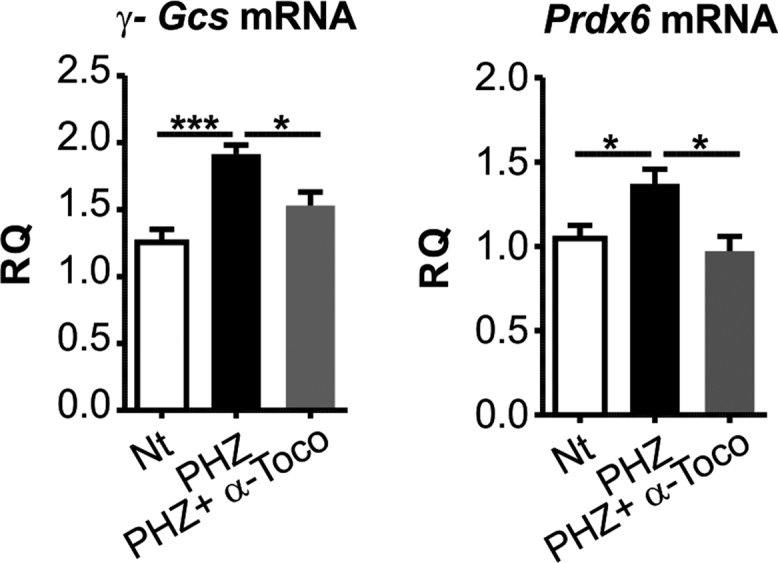
α-tocopherol protects the heart against PHZ-mediated oxidative stress. Data on the heart of PHZ-treated Wt mice administered or not with α-tocopherol are shown. (A) qRT-PCR analysis of γ-Gcs and peroxiredoxin 6 (Prdx6) mRNA levels of PHZ- and PHZ-α-tocopherol-treated mice (n=7) 4 weeks after the treatment. One-way analysis of variance with Bonferroni post-test analysis were performed. ⁎P < 0.05; ⁎⁎⁎P < 0.001. Values represent mean ± SEM. RQ, relative quantity.